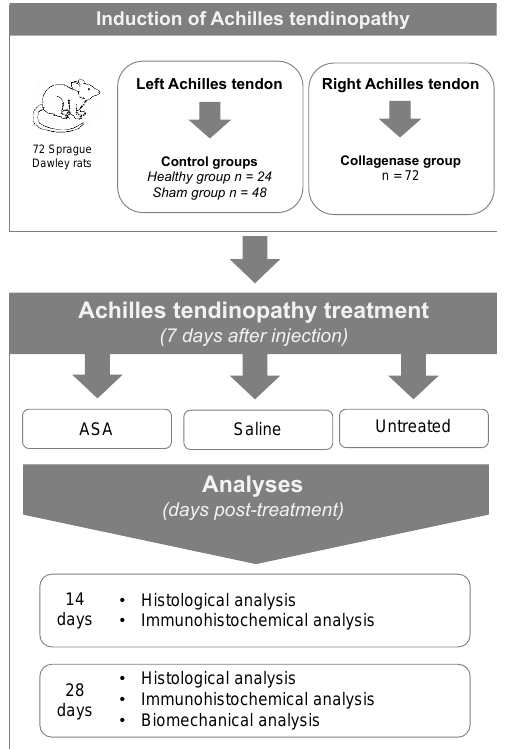
Figure 1. Experimental design for induction of Achilles tendinopathy. 72 Sprague Dawley rats underwent collagenase-induced tendinopathy in their right Achilles tendon. 24 of these rats had untouched left Achilles tendons (healthy controls), while 48 of these rats had dry needling on their left Achilles tendons (sham controls). Seven days following collagenase injection, rats were either treated with saline (vehicle control), amniotic suspension allograft (ASA), or left untreated. Fourteen days post-treatment, tendons were collected for histological analysis and immunohistochemical